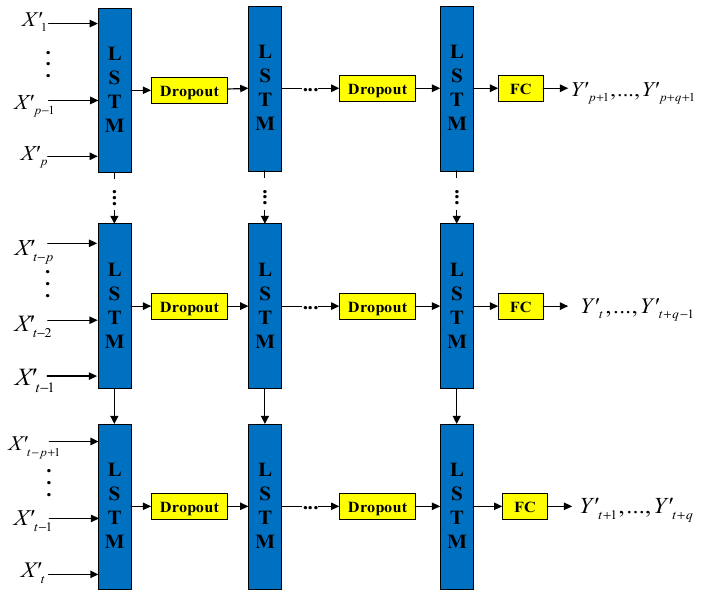
Figure 4. Aviation safety prediction model based on MSSLSTM.